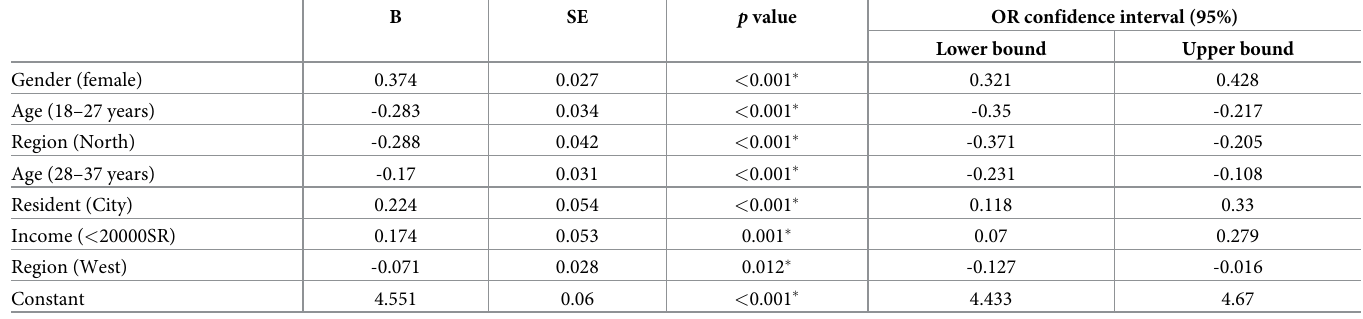
Table 7. Multiple linear regression analysing the associations between demographic characteristics and calculated scores of participants in relation to hand hygiene and wearing gloves/masks when leaving the home.